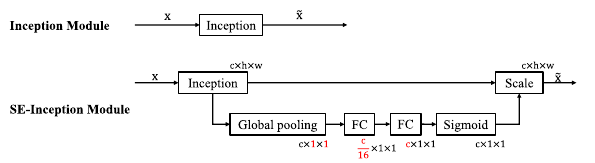
Figure 6. SE-Inception Network Architecture